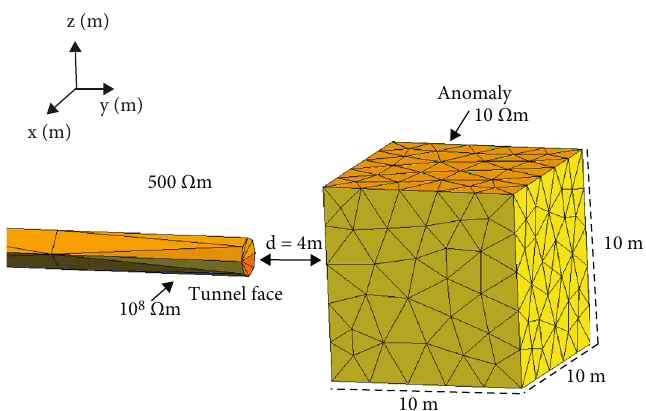
Figure 7: Schematic diagram of circular tunnel and unstructured mesh used in the FE